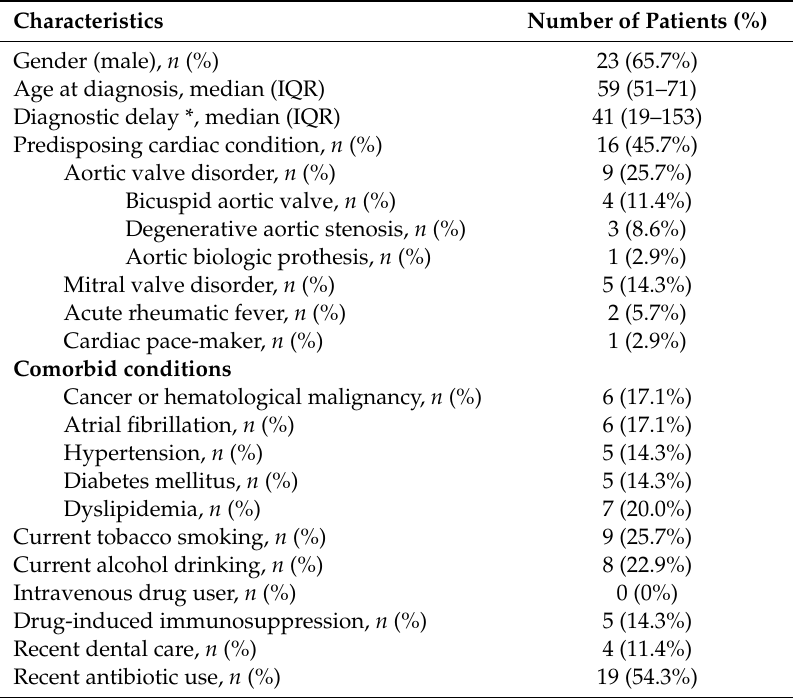
Table 1. Patients’ characteristics at